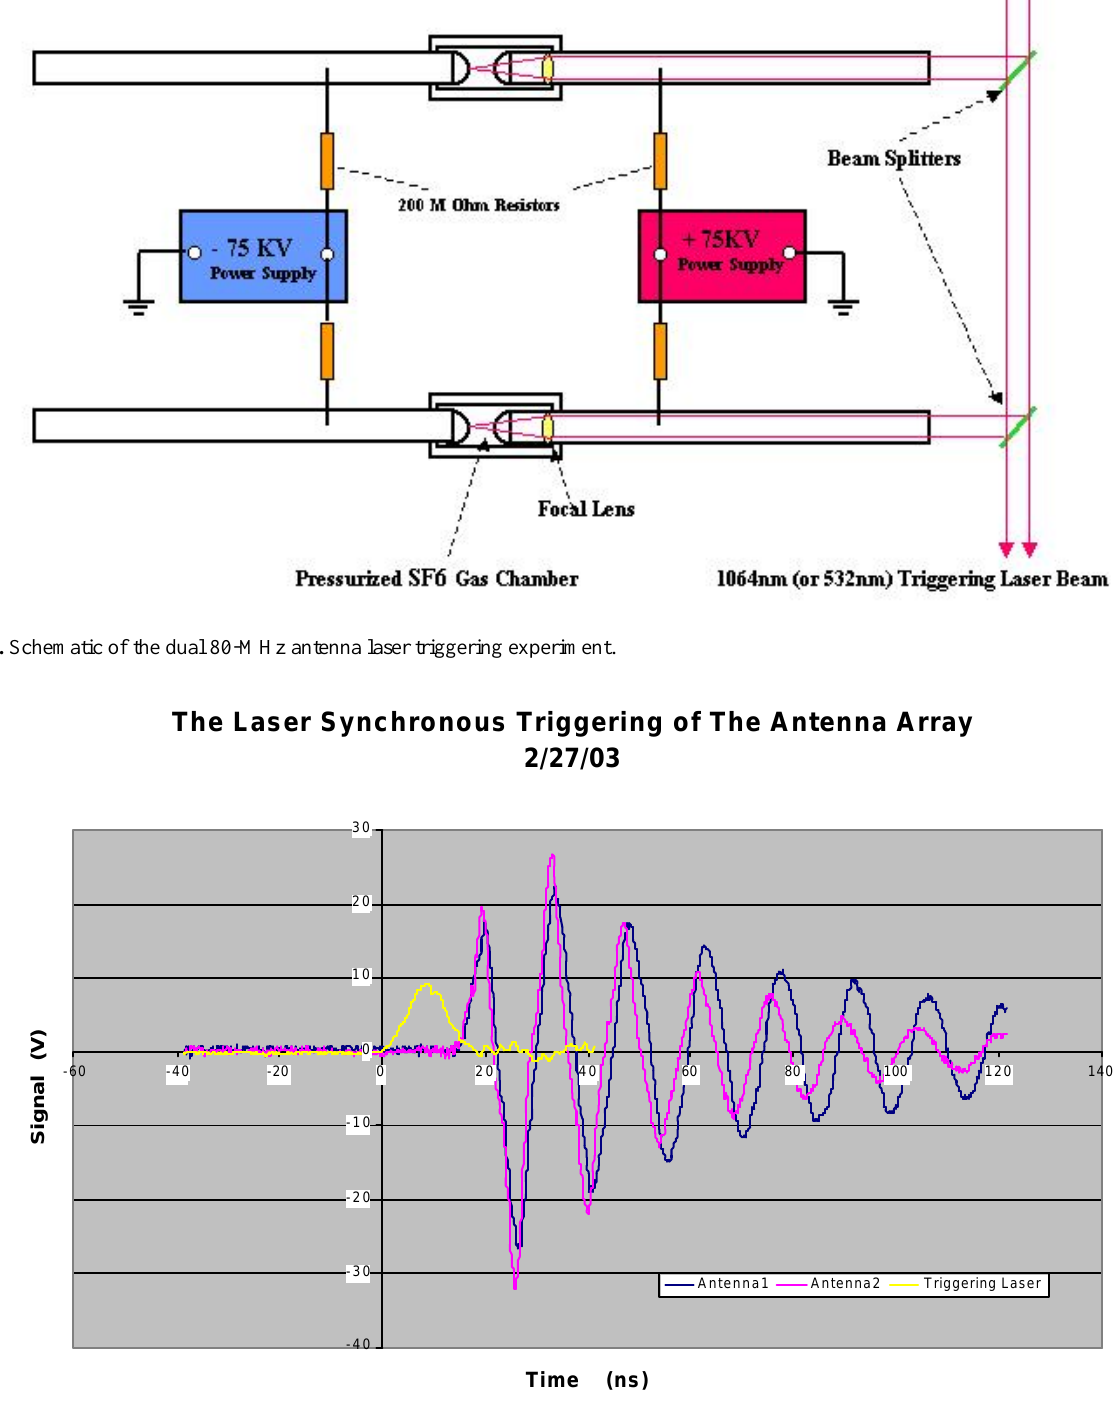
Fig. 8. Multi trace oscillogram showing the derivatives of the two 80-MHz antenna currents (black and violet traces), triggered by the 0.5 J – 10–15ns (532nm) pulse (yellow trace) from a doubled YAG solid-state